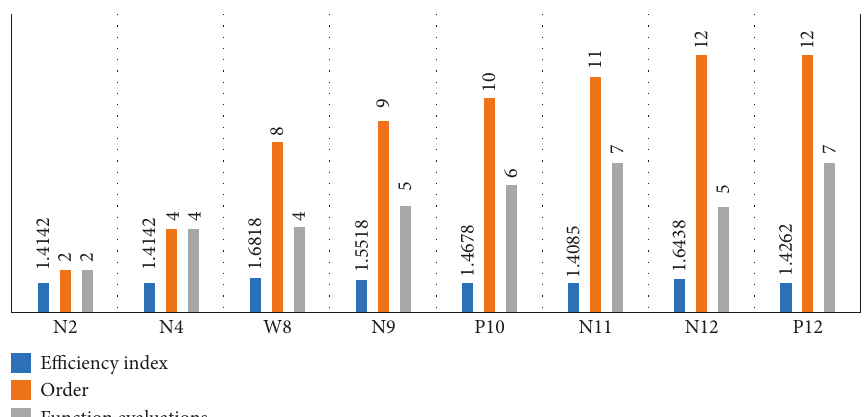
Figure 2: Comparison of the methods under consideration on the basis of efficiency index, order of convergence, and number of function